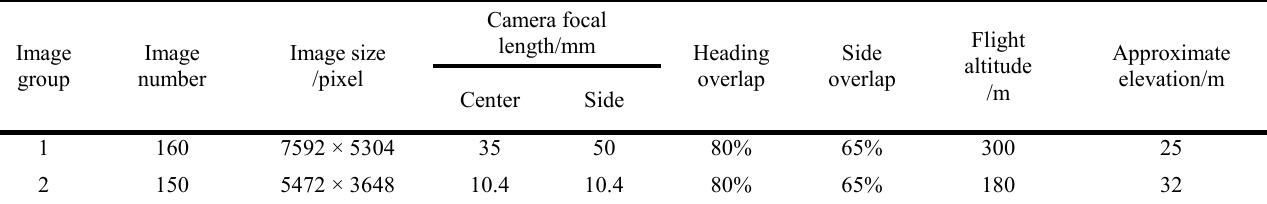
Table1 Experimental data information